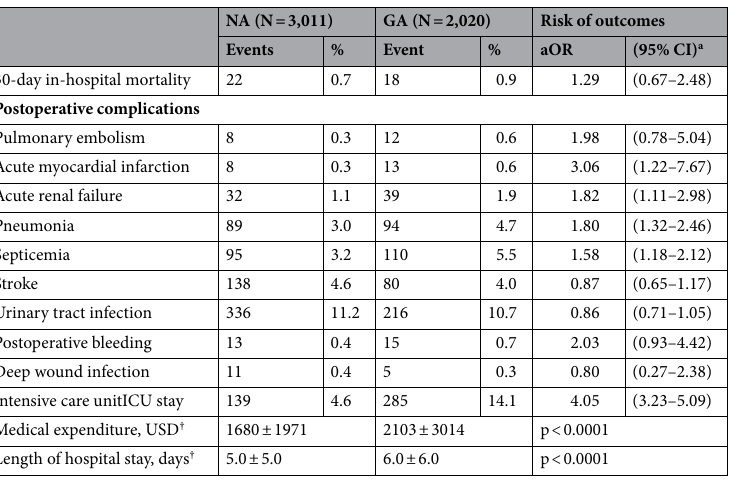
Table 4. Adverse outcomes after surgeries in patients with aortic stenosis received neuraxial and general anesthesia (N = 5031). aOR adjusted odds ratio, CI confidence interval, GA General anaesthesia, NA Neuraxial anaesthesia, OR odds ratio. a Adjusted for all covariates listed in Table 1. † Median (interquartile